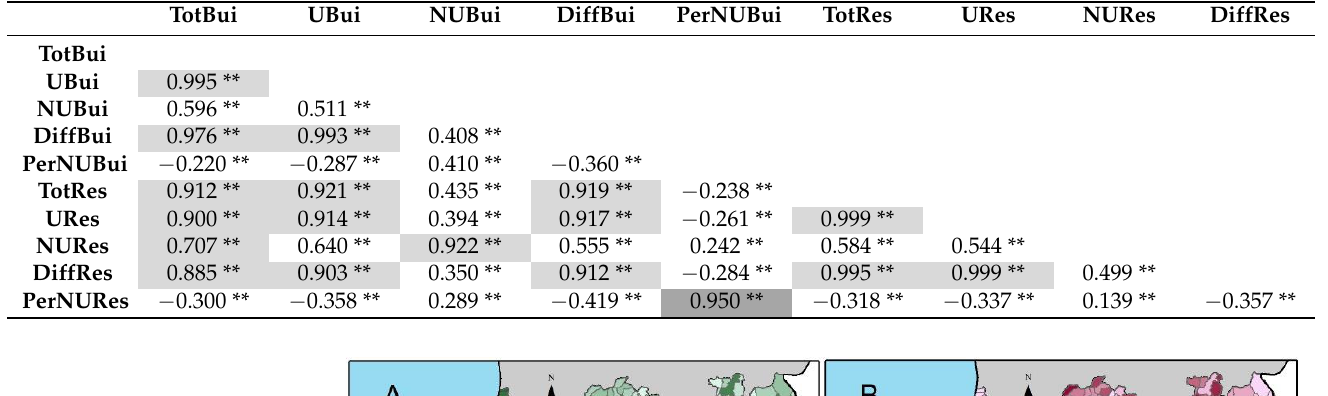
Table 1. Pearsoncorrelationcoefficientsbetweenthepotentialexposuredescriptors. Values ≥ 0.7highlighted in grey. The two grey tones are intended to differentiate groups of collinear variables, considered to express different dimensions of exposure. TotBui—total number of buildings; UBui—number of urban buildings; NUBui—number of non-urban buildings; DiffBui—difference between urban and non-urban buildings; PerNUBui—percentage of total buildings that are non-urban; TotRes—total number of residents; Ures—urban residents; NURes—non-urban residents; DiffRes—difference between urban and non-urban residents; PerNURes—percentage of total residents that are non-urban. ** Significant at the p = 0.01 level.